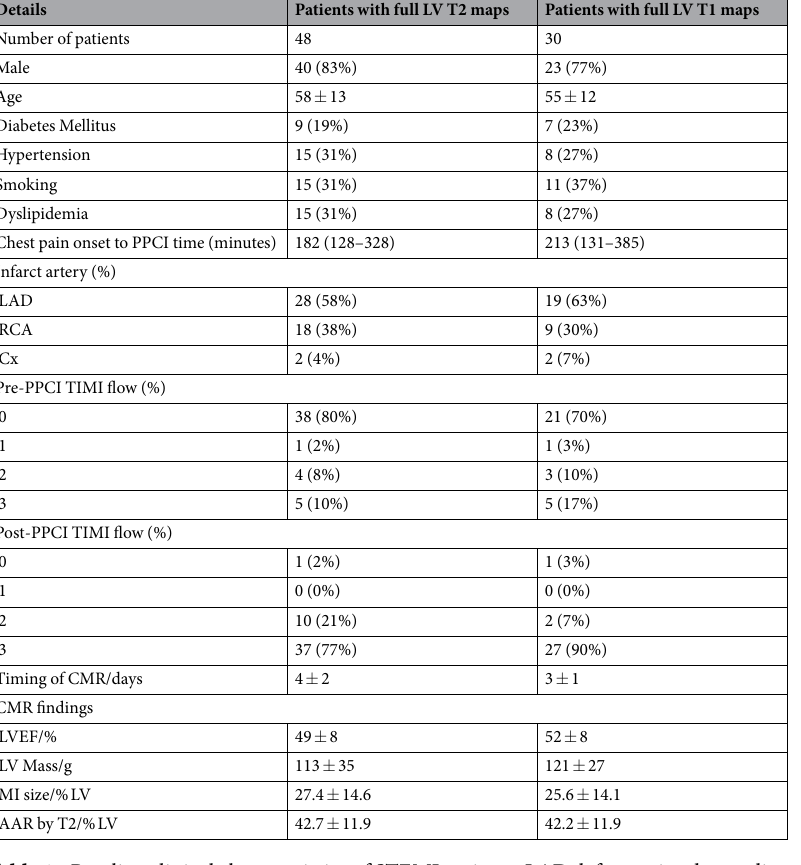
Table 1. Baseline clinical characteristics of STEMI patients. LAD: left anterior descending artery; RCA: right coronary artery; Cx: circumflex artery; TIMI: thrombolysis in myocardial